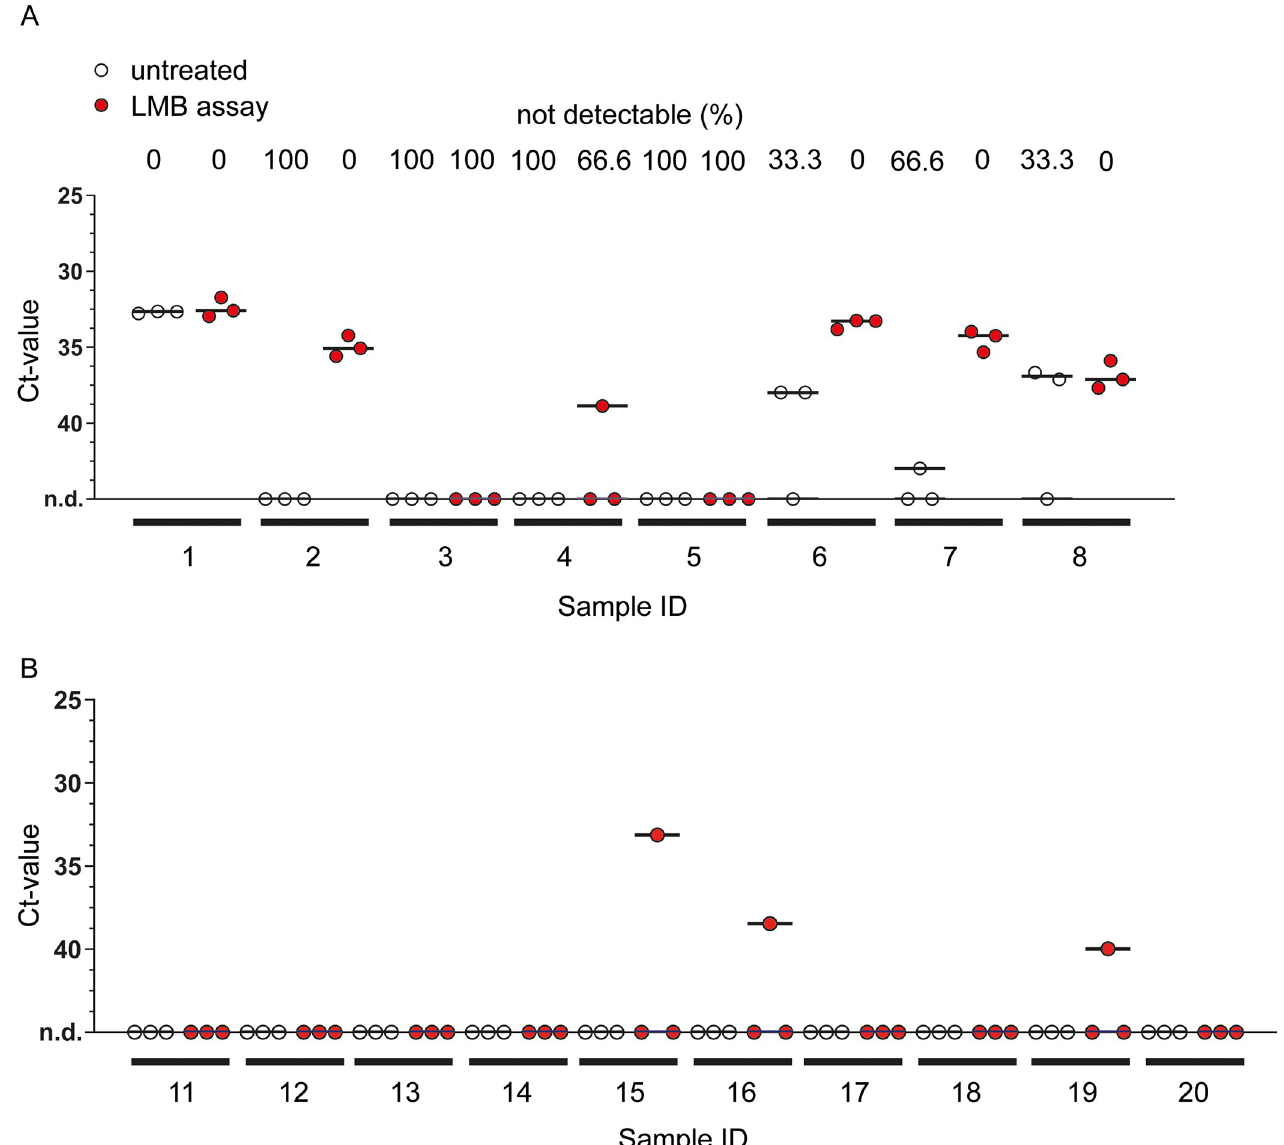
Fig 5. The effect of LMB assay on qPCR-based detection of Mtb in saliva from TB patients and healthy subjects (cohort #2). Saliva samples from TB patients (A) and healthy subjects (B) were divided into two fractions that were either left untreated or were incubated with LMBs (LMB assay) before undergoing heat treatment, DNA isolation, and qPCR analysis. Analysis of three technical replicates is shown with the line at median. For TB patients (A), the percentage (%) of samples in which no signal could be detected (not detectable, n.d.) is given above the graph. Statistical analysis was conducted with a non- parametric analysis of variance for repeated measurements comparing untreated vs LMB assay-treated samples (A): p =